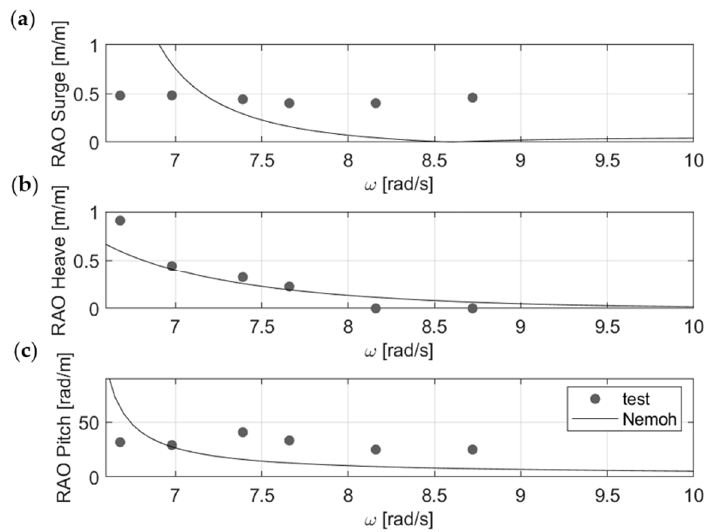
Figure11. RAOsforthethreeDoFasresultedfromtheexperiments(dots)andbyNEMOHcomputations Figure 11. RAOs for the three DoF as resulted from the experiments (dots) and by NEMOH in absence of mooring (solid line). Surge ( a ), heave ( b ), and pitch ( c computations in absence of mooring (solid line). Surge ( a ), heave ( b ), and pitch ( c ).